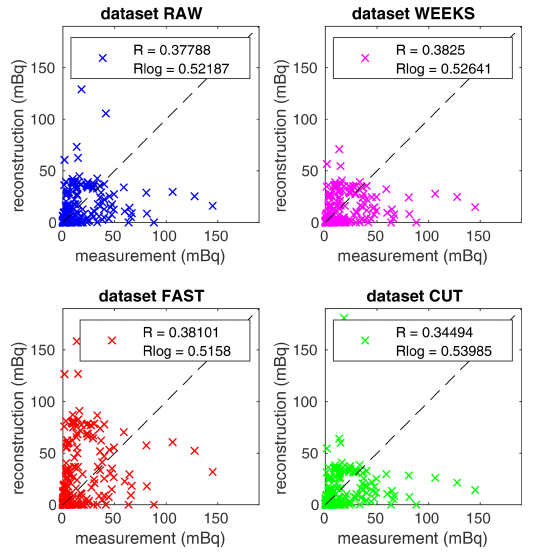
Figure 9. Scatterplots between the IAEA measurements and recon- structions using the FAST dataset for all four considered locations (specified in the titles). Computed correlation coefficients and cor- relation coefficients of the logarithm of concentrations are given in the